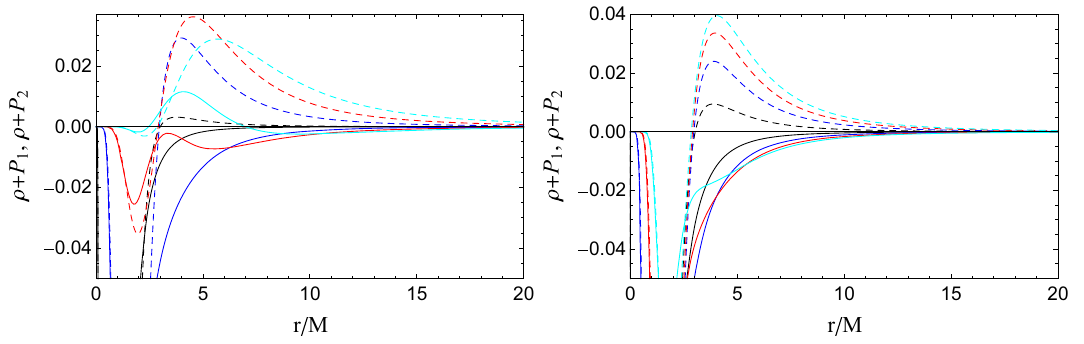
Fig. 1 Violation of the NEC ( ρ + P 1 — solid curves , ρ + P 2 – dashed curves ) of the non-singular non-rotating black hole spacetime. Left panel N = 3, and the values of the dimensionless parameter L / M : L / M = 0 . 3 ( black curves ), L / M = 1 . 2 ( blue curves ), L / M = 2 ( red